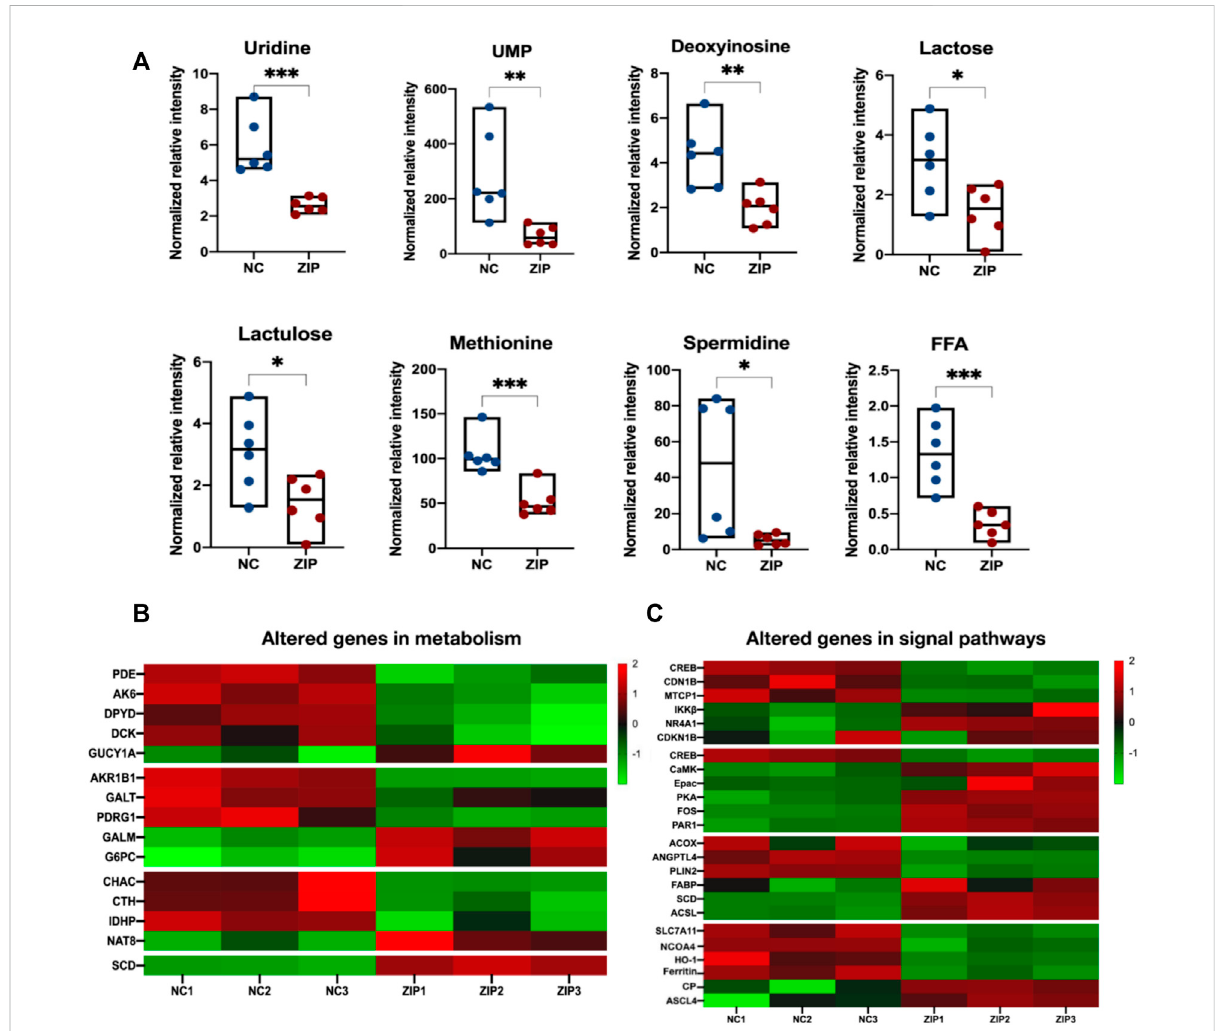
FIGURE 5 Integrated analysis result of altered metabolites and genes in metabolism and signal pathways. (A) 8 metabolites were indicated to be signi fi cantly altered and were all downregulated. The Y -axis displays the relative intensity and the X -axis the experimental groups. The upper and lowerhorizontallines represent themaximumand minimum values, themiddle linesrepresentthemedian,and thedots represent thesamples. * p < 0.05, ** p < 0.01, *** p < 0.001, as determined by Student ’ s t -test. (B , C) The heatmap of altered genes in metabolism and signal pathways triggered by SLC39A1 in OSRC-2 cells. Red indicates upregulated and green downregulated